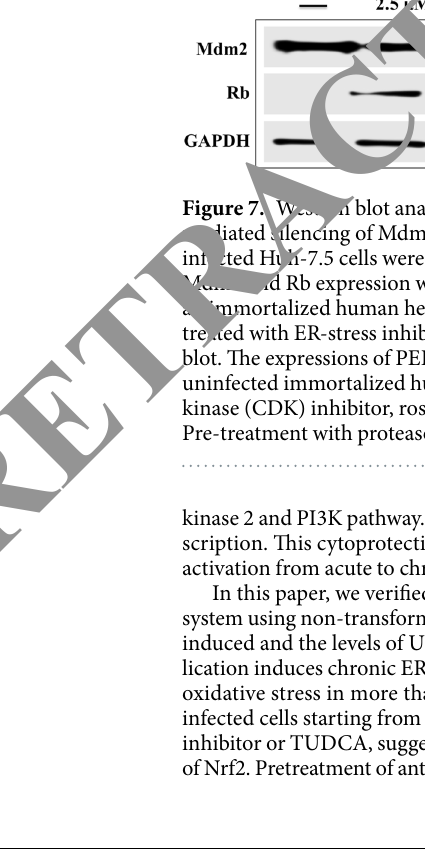
10 SCieNTifiC REPORtS | 7: 9223 | DOI:10.1038/s41598-017-10087-6